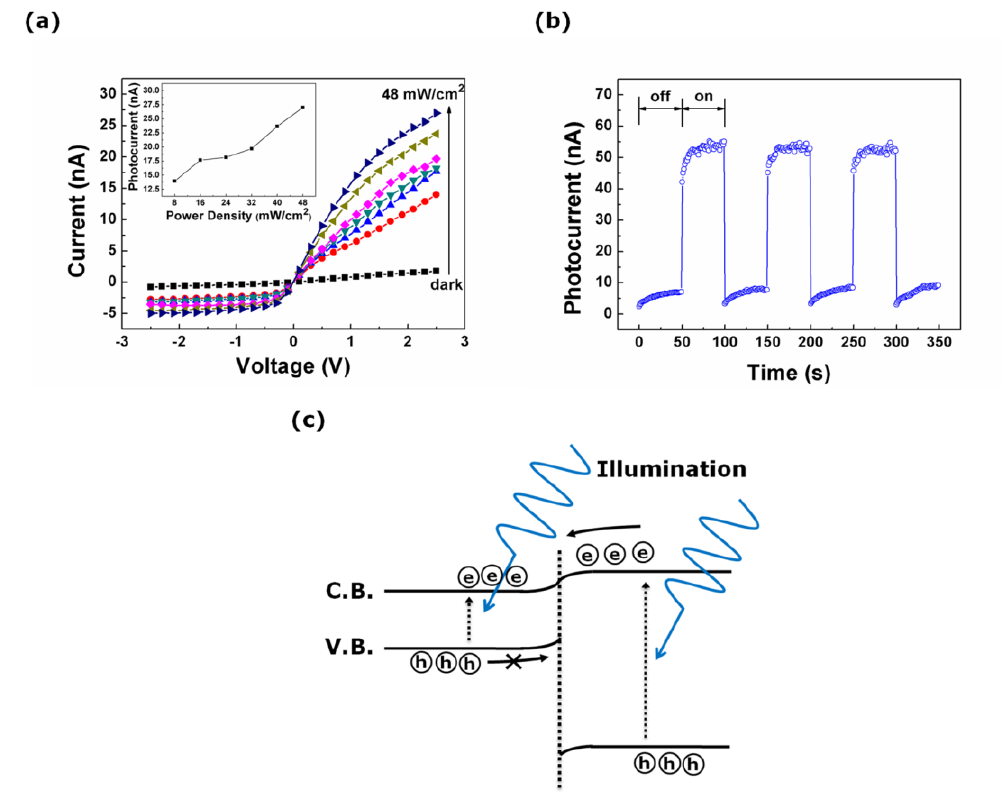
Figure 3. Optoelectronic characteristics of a p -type Si NW/ n -type ZnO film photodiode. (a) The photocurrent characteristics under the illumination of the 325-nm wavelength light and the magnitude of the photocurrent depending on the power density of the light (inset); (b) the photocurrent transients under periodic illumination of light at a bias of 2.5 V; and (c) schematic energy band diagram in forward bias condition under the illumination of the 325-nm wavelength